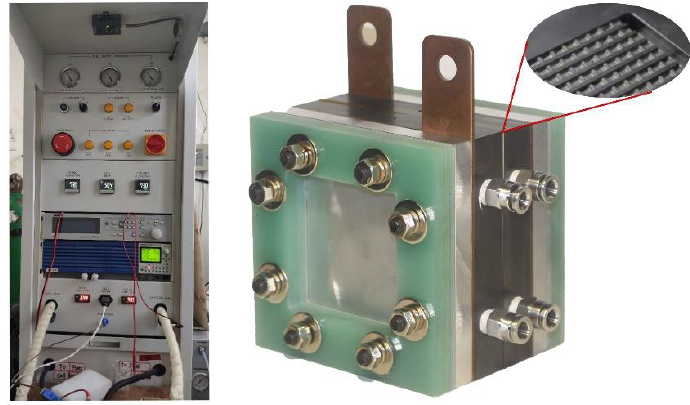
Figure 3. The test bench and PEMFC single cell. Table 3. Detailed parameters of PEMFC single cell.